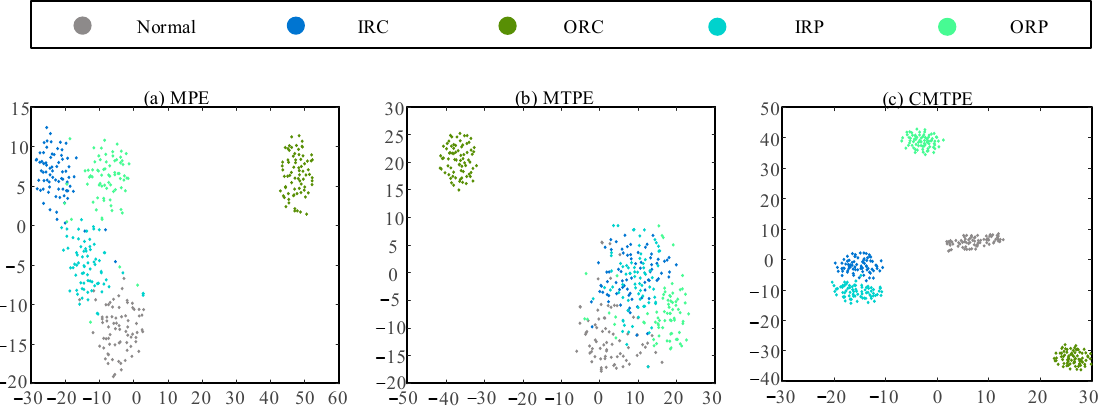
Figure 12. Visualization of features extracted by three multiscale entropy methods: ( a ) MPE method; ( b ) MTPE method; ( c ) CMTPE method. ( b ) MTPE method; ( c ) CMTPE